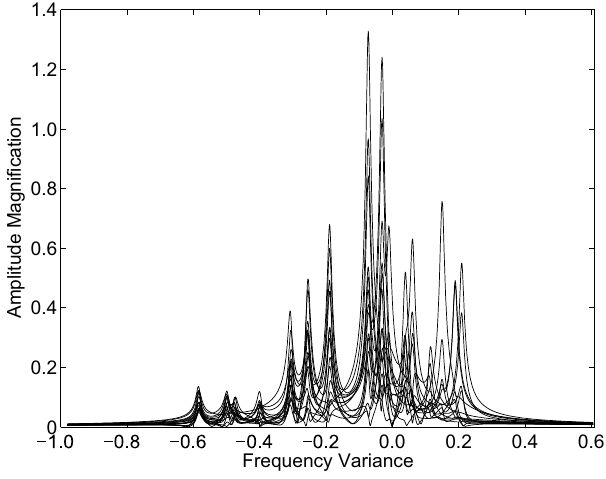
Fig. 7. Normalized mistuned blisk